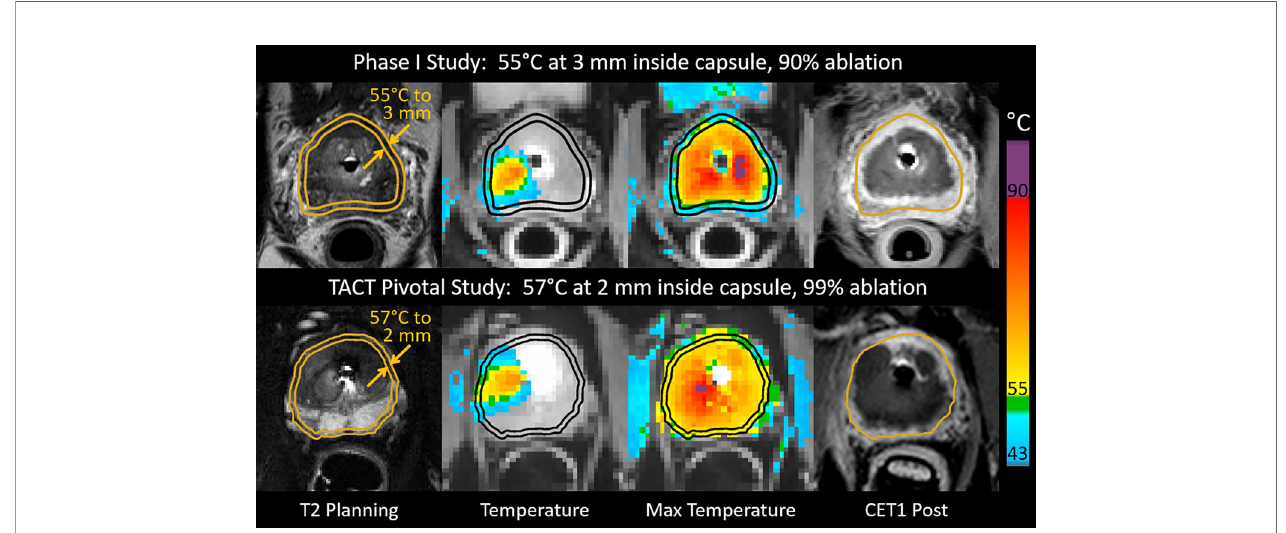
FIGURE 1 | Intraoperative images from patients who underwent MRI-guided transurethral ultrasound ablation (TULSA) using conservative treatment parameters in the Phase I study (top), and intensi fi ed parameters designed to achieve whole-gland ablation in the pivotal study (bottom). Transverse images at one location in the midgland for each patient depict interoperative treatment planning on T2-weighted images, real-time MRI temperature images used to control treatment, maximum temperature projections used to assess ablation coverage during treatment, and post-treatment contrast-enhanced T1-weighted images (CET1) demonstrating greater ablation extent in the example from the pivotal study